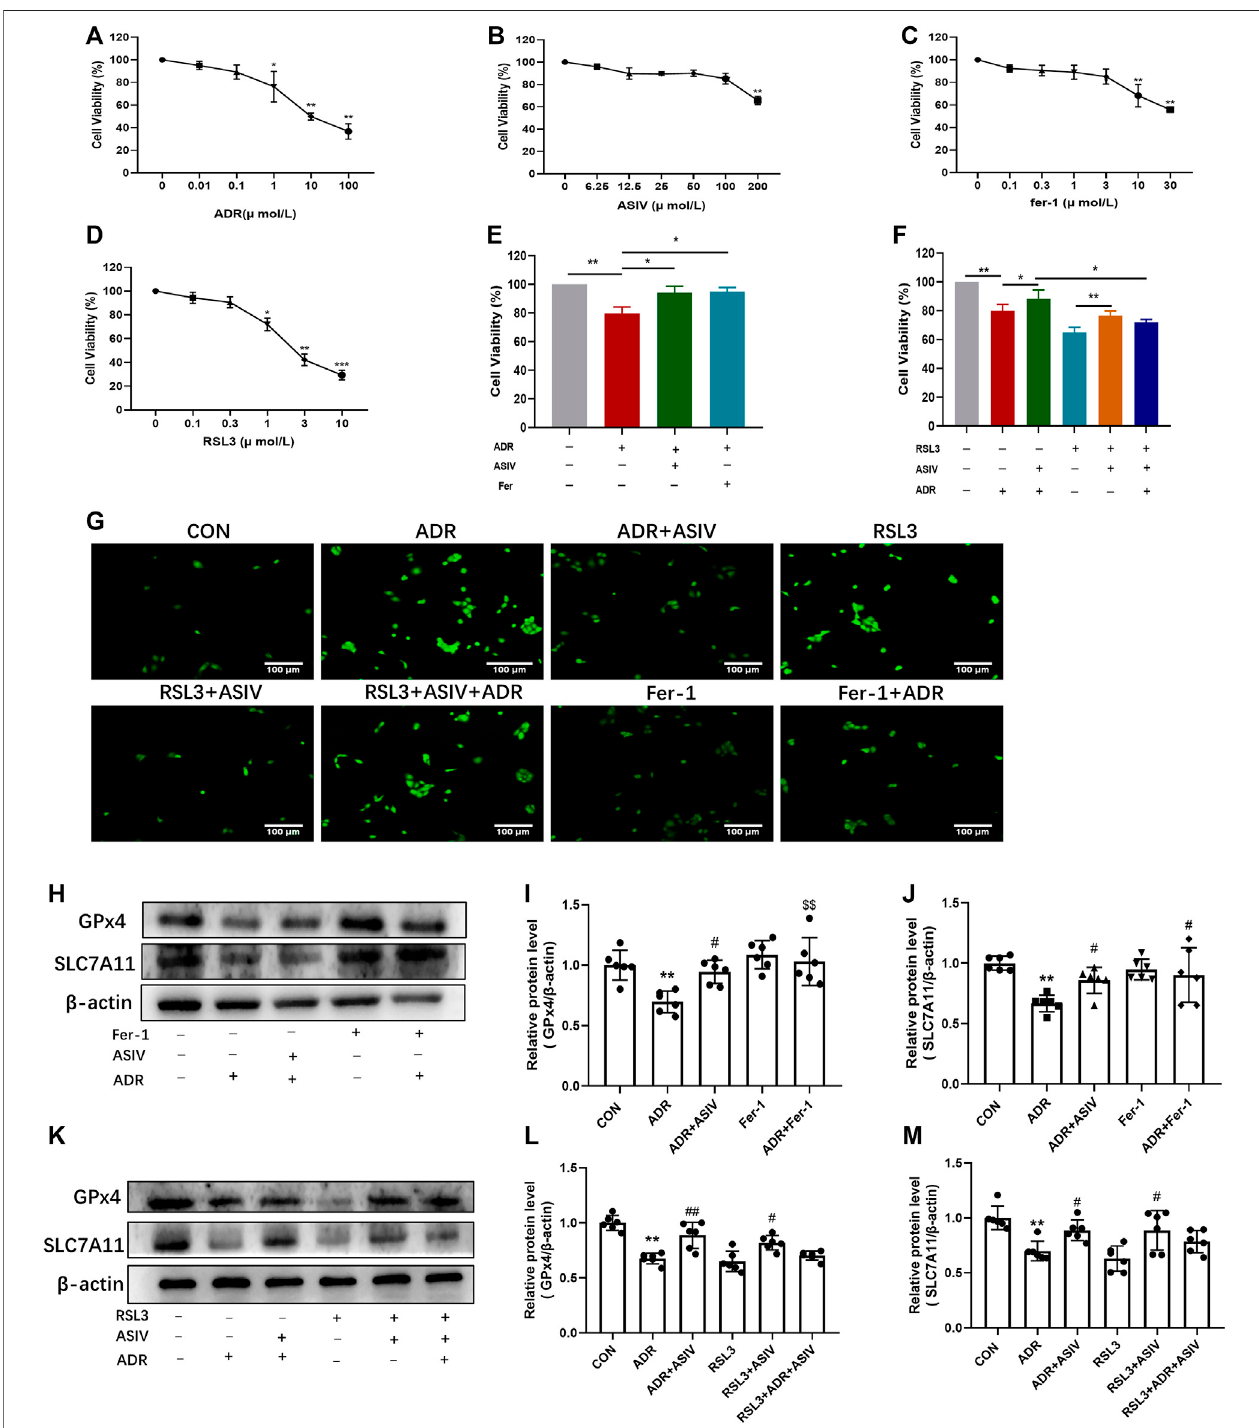
FIGURE 5 | ASIV alleviated ADR-induced ferroptosis was associated with the inhibition of the Pi3K/Akt and Nrf2 pathways in vitro . The CCK-8 assay was used to determinethecellviabilityofHK-2cellsafter24 htreatwithADR (A) ,ASIV (B) ,Fer-1 (C) ,andRSL3 (D) .HK-2cellsweretreatedwith1 µMADRand100 µMASIVor3 µM fer-1 (E) or 1 µM RSL3 (F) for 24 h. HK-2 cell viability was detected by the CCK-8 assay. The cellular ROS was detected after treatment (G) . Protein expression of ferroptosis-relatedproteins (H,K) ,including GPx4 (I,L) and SLC7A11 (J,M) wasused todetect after co-treatment ofADR and ASIV or fer-1. Datawere expressed as mean ± SD, n = 6. * p < 0.05, ** p < 0.01 vs. CON group. # p < 0.05, ## p < 0.01 vs. ADR group.